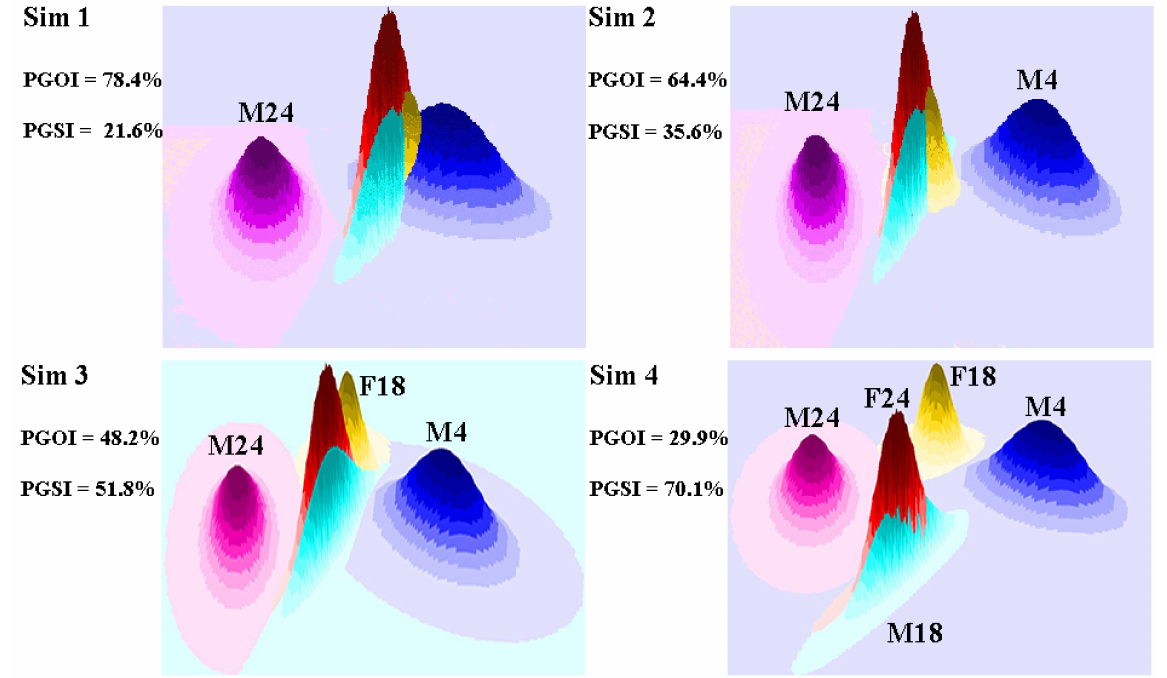
Figure 4. Resulting behavior of the PGOI and PGSI applied to simulated patterns of home range overlap. For each simulation, the IDs of the individuals whose probabilistic home ranges were shifted with respect to their original positions are shown. IDs are the same as those in Table